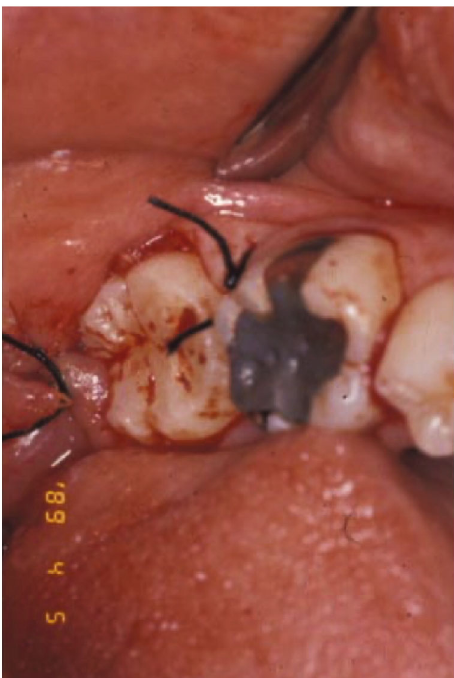
Figure 3: Panoramic radiograph showed that horizontal impaction of #17 was noted. The apical part of #17 was fully